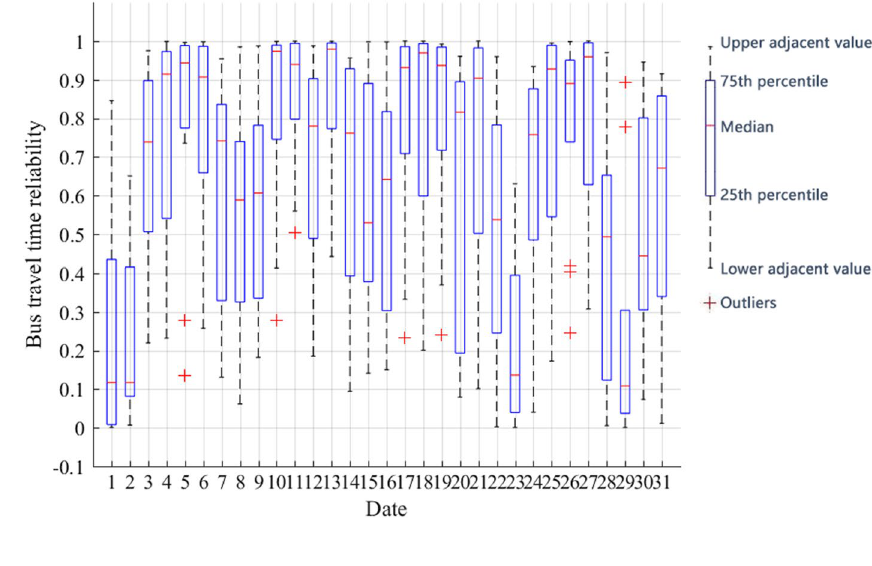
Fig. 4 Bus travel time reliability in December 2012